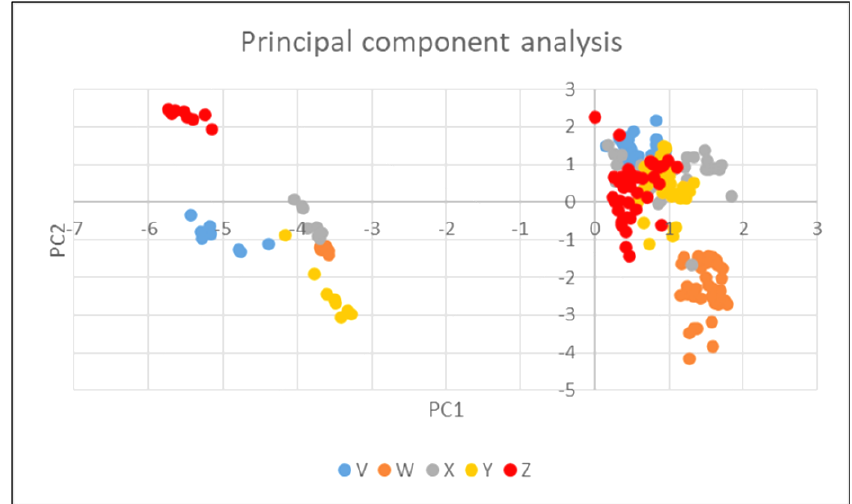
Figure 4. Principal Component Analysis: Effect of cephalosporins on pH value, titratable acidity value, and organic acids concentration at the end of fermentation.